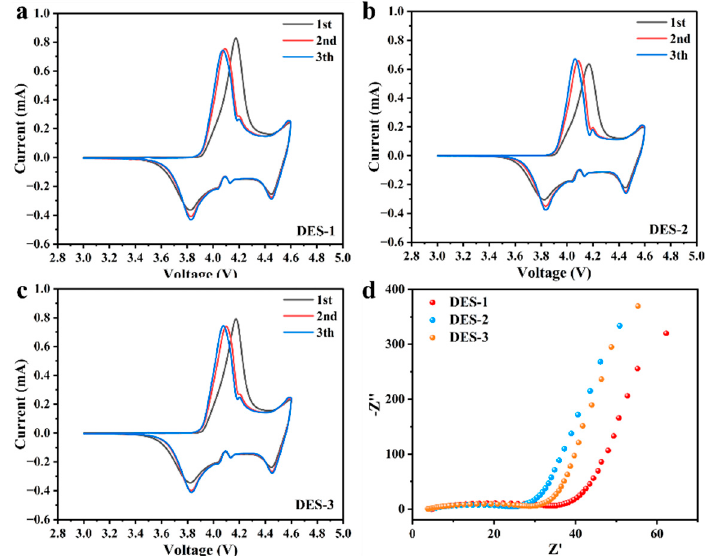
Figure 4. The cyclic voltammetry (CV) of LCO||Li cells from 3.0–4.6 V with ( a ) DES-1, ( b ) DES-2, and ( c ) DES-3. ( d ) The electrochemical impedance spectroscopy (EIS) of LCO||Li cells with three DES electrolytes before cycle.